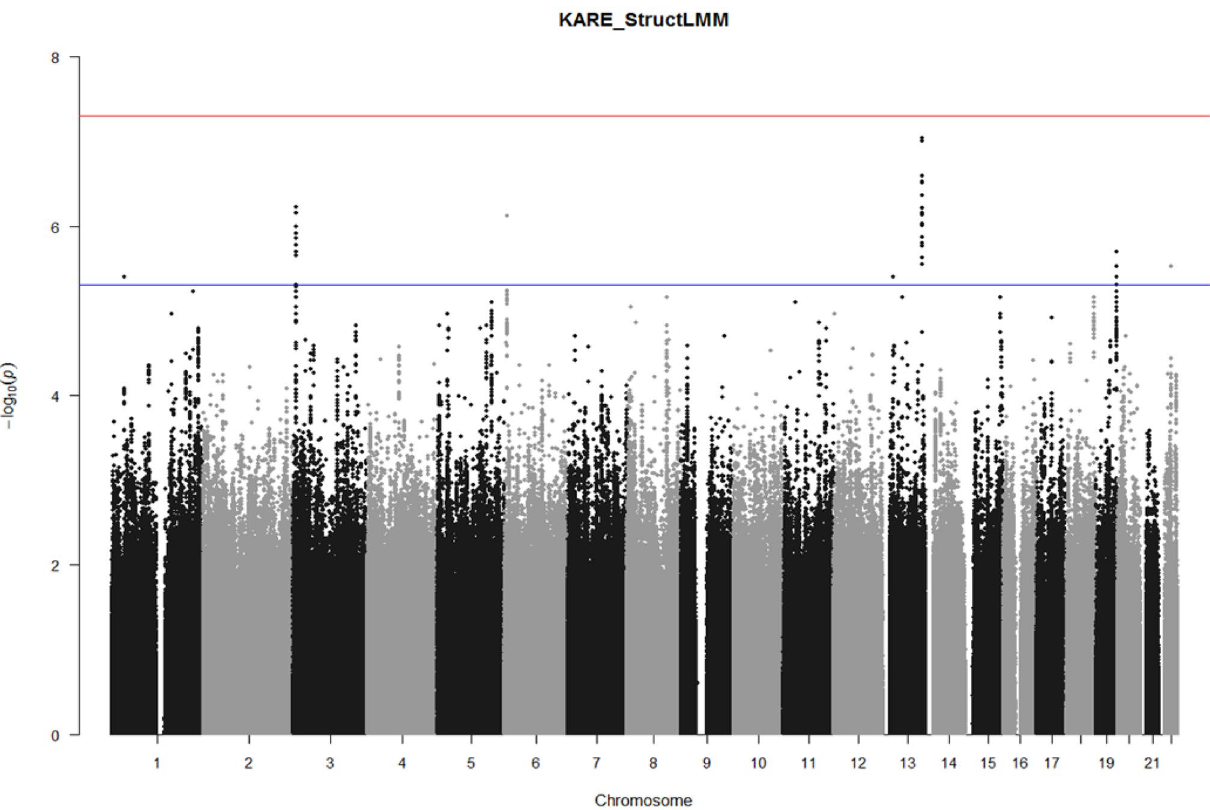
Figure 2. Manhattan plots for genome-wide interaction study using eight environmental factors. The red line indicates the suggestive threshold ( P value < 5.00 × 10 −6 ). The blue line indicates the genome-wide significance threshold ( P value < 5.00 × 10 −8 ).